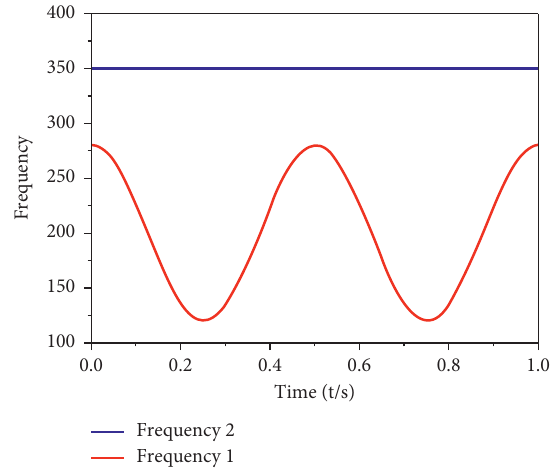
Figure 7: Actual frequency ridge